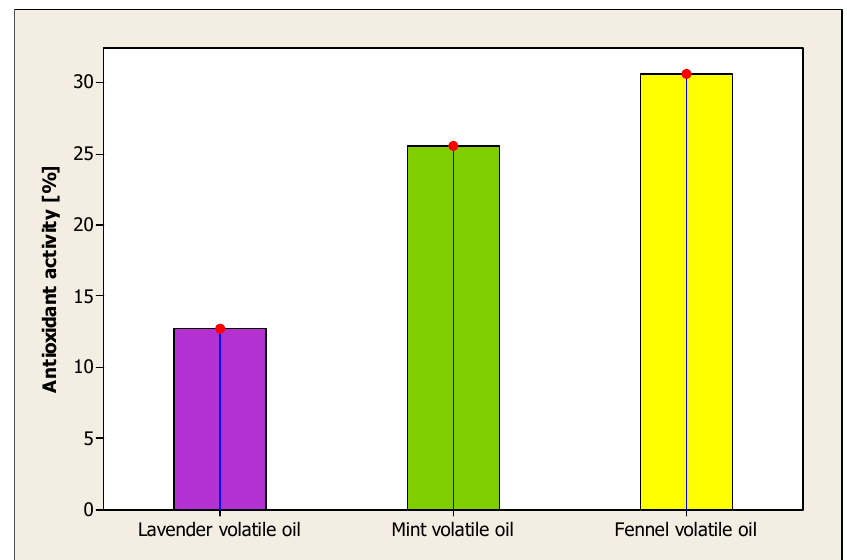
Figure 2. Antioxidant activity for the three assortments of volatile oils used in encapsulation.